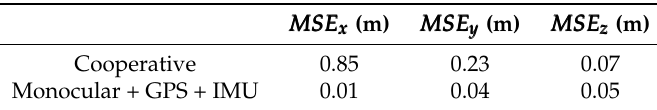
Figure 13. Estimated trajectory of Quad 1 obtained with the two configurations. Table 4. Mean squared error in the position estimation.